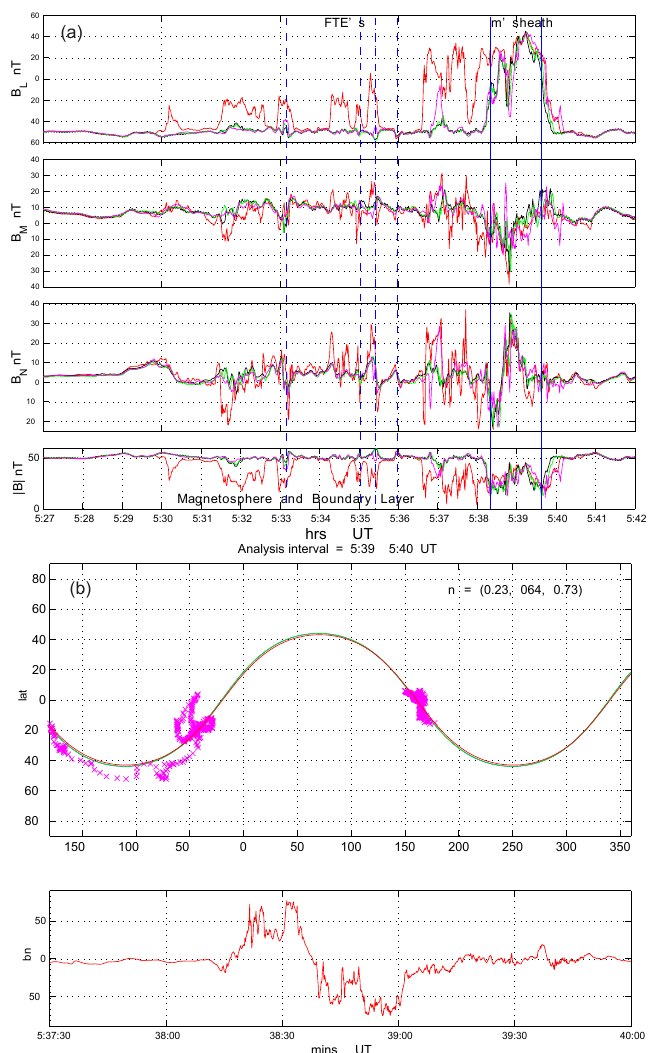
Fig. 7. (a) As for Fig. 4a but for crossing 4. The interval is chosen to correspond to the extended sequence of multiple crossings by spacecraft 2. The dashed vertical lines indicate selected FTE signatures and the short period when all spacecraft exit into the magnetosheath is shown by solid vertical lines. (b) Analysis of the boundary at 05:40